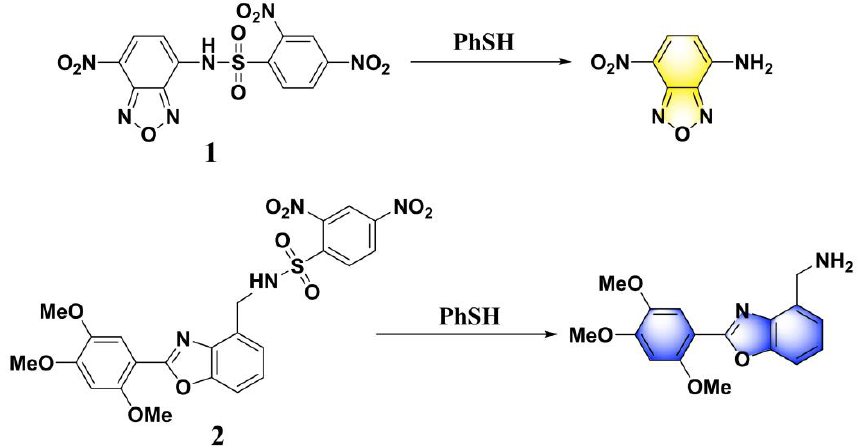
Figure 1. Structures and reactions of probes 1 and 2 with thiophenol (PhSH).